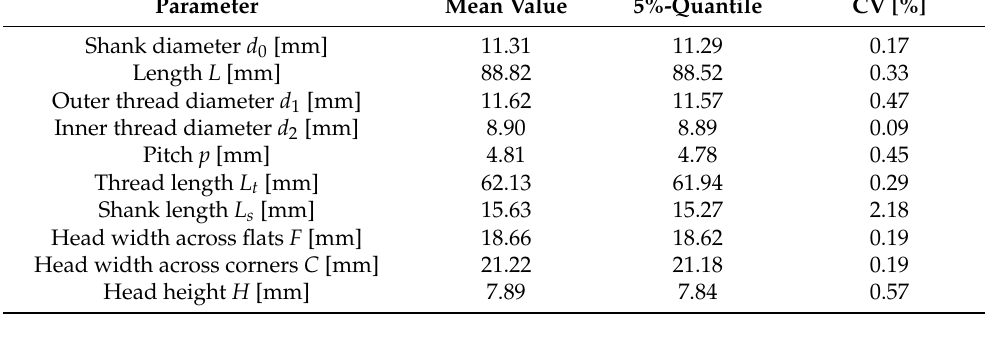
Table 5. Mean values, 5%-quantiles and coefficients of variation for the 12 mm screw used in the tests.